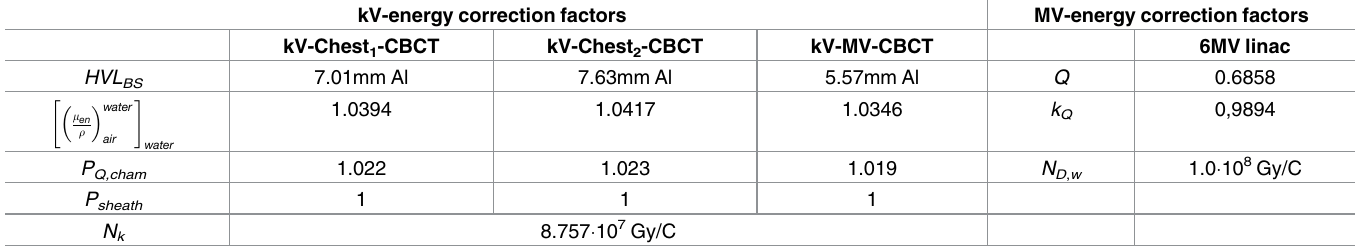
Table 2. Absolute dose correction factors for kV- and MV-energy, based on AAPM TG61 report and IAEA TRS 398, respectively, whereas the val- ues for HVL BS and Q were calculated from the beam quality